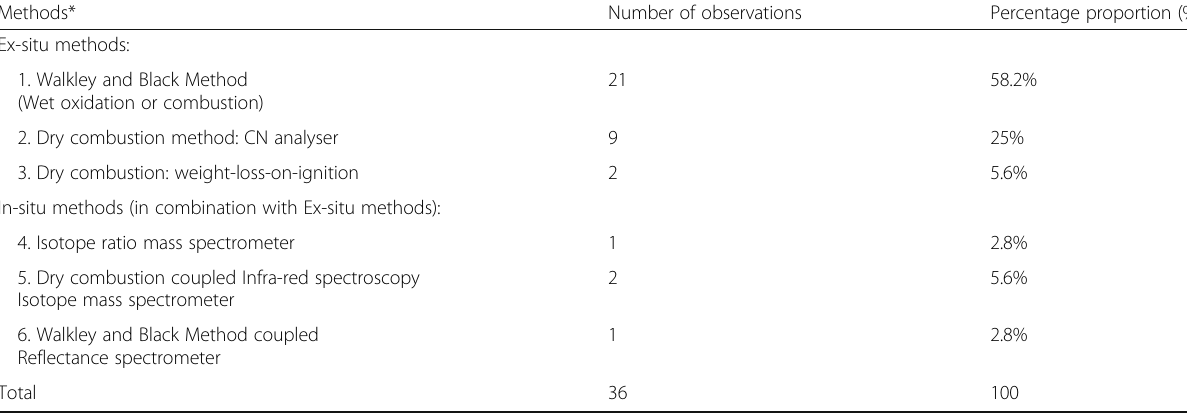
Table 1 Different methods of soil carbon determination used in referred authors